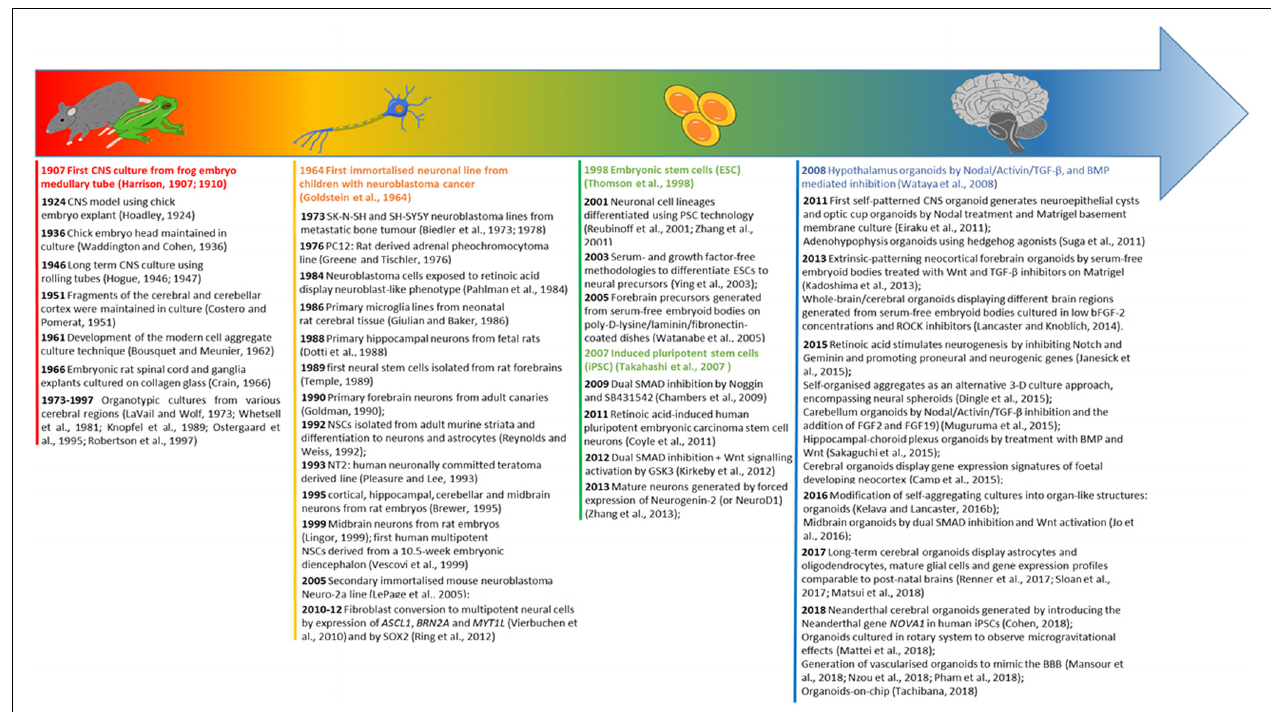
FIGURE 2 | Evolution timeline of CNS modelling. The timeline illustrates the evolution from organ explants to the use of 2-D neural cell lines, and subsequently a shift toward pluripotent stem cell derived neural cultures leading to the development of CNS specific organoids. For each category of modelling a time excursus is presented chronologically over 100